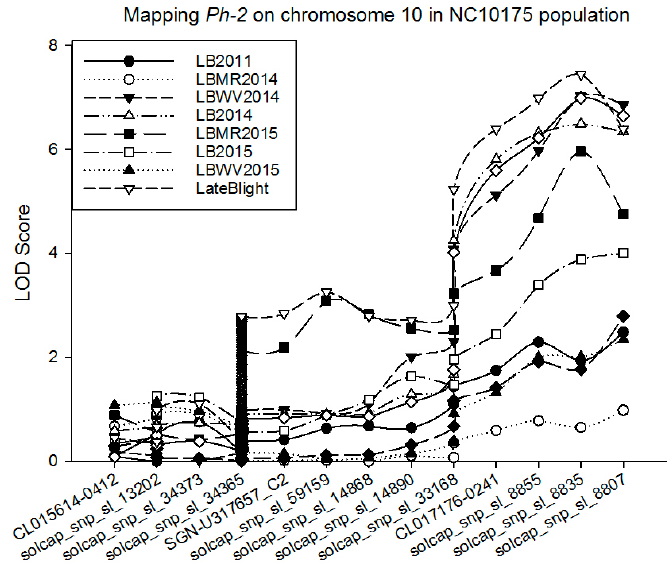
Figure 3. Mapping Ph-2 on chromosome 10 in segregating tomato population derived from an intra-specific cross. Molecular markers and its position information is given in Table 3. LB2011 = Late blight trial conducted in 2011; LBMR2014 = Late blight trial conducted at MHCREC at Mills River in 2014; LBWV2014 = Late blight trial conducted at MRS, Waynesville, NC in 2014; LB2014 = Average late blight data from MHCREC and MRS in 2014; LBMR2015 = Late blight trial conducted at MHCREC at Mills River in 2015; LBWV2015 = Late blight trial conducted at MRS, Waynesville, NC in 2015; LB2015 = Average late blight data from MHCREC and MRS in 2015. Y -axis shows the LOD score and X -axis shows the marker